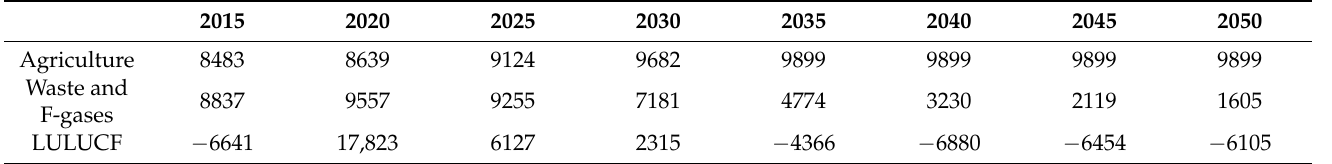
Table 2. Exogenous assumptions about the evolution of GHG emissions from agriculture, waste, and F-gas and LULUCF [kt CO 2ek